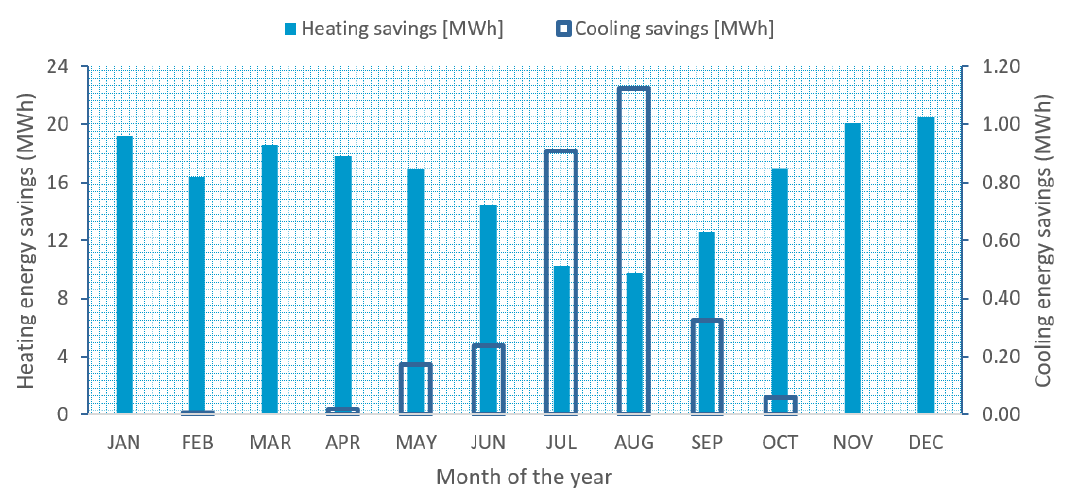
Figure 17. Monthly cooling energy demand of the surgical suite during COM and OUM.